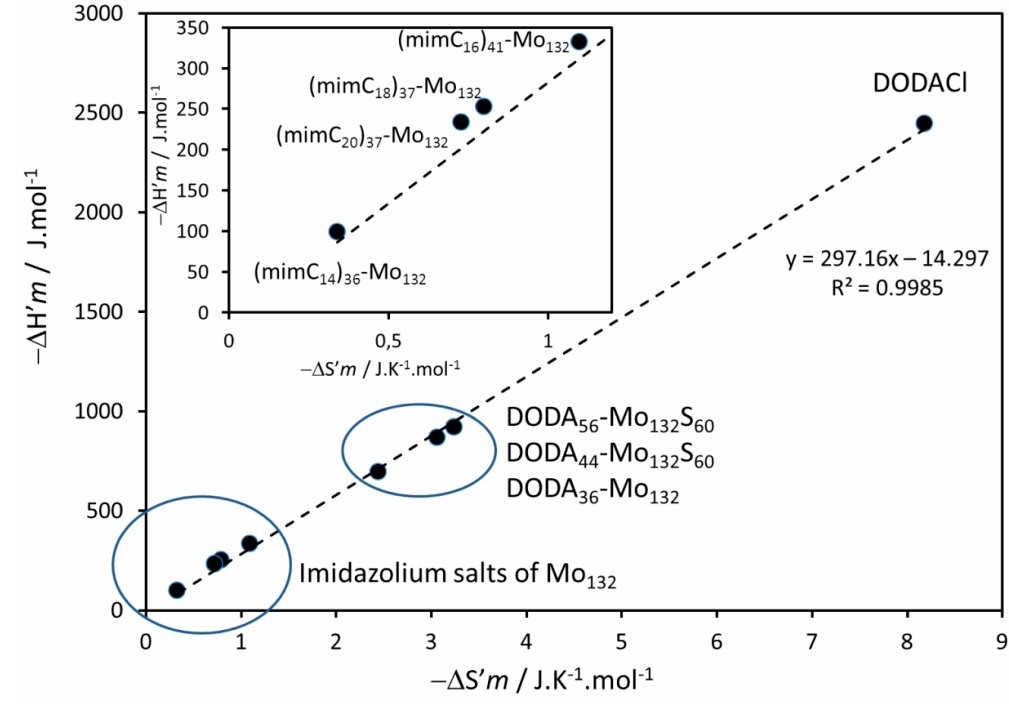
Figure 7. Δ H' m versus Δ S' m